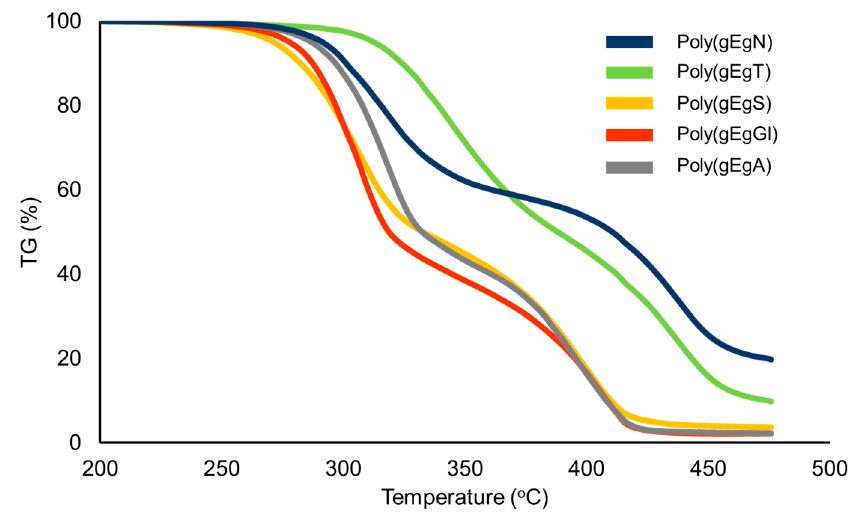
Figure 2. Thermogravimetric analysis (TG) curves of the selected poly(ester amide)s with gEg components.